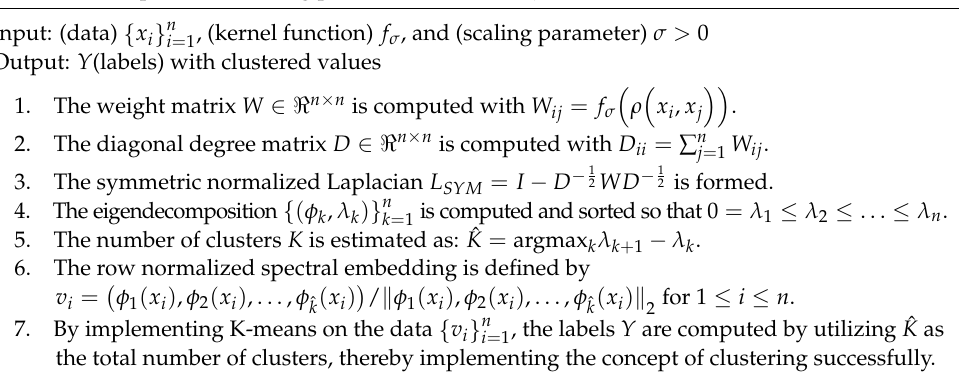
Algorithm 1: Spectral clustering process with a metric ρ